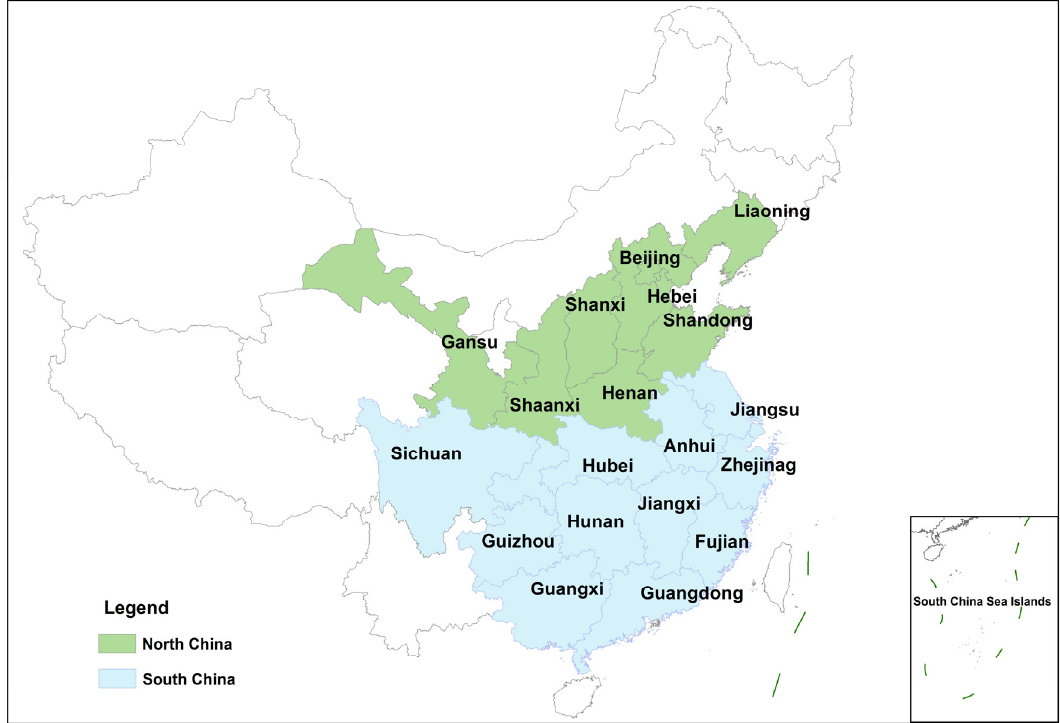
Figure 1. Study area in the paper. In the North China Plain: Beijing, Hebei, Shandong, and Henan; In the Loess Plateau: Shanxi, Shaanxi, and Gansu; In the Yangtze River Basin: Sichuan, Guizhou, Hubei, Hunan, Anhui, Jiangxi; Jiangsu, and Zhejiang; andIn the Jiangnan region: Fujian, Guangxi and Guangdong.